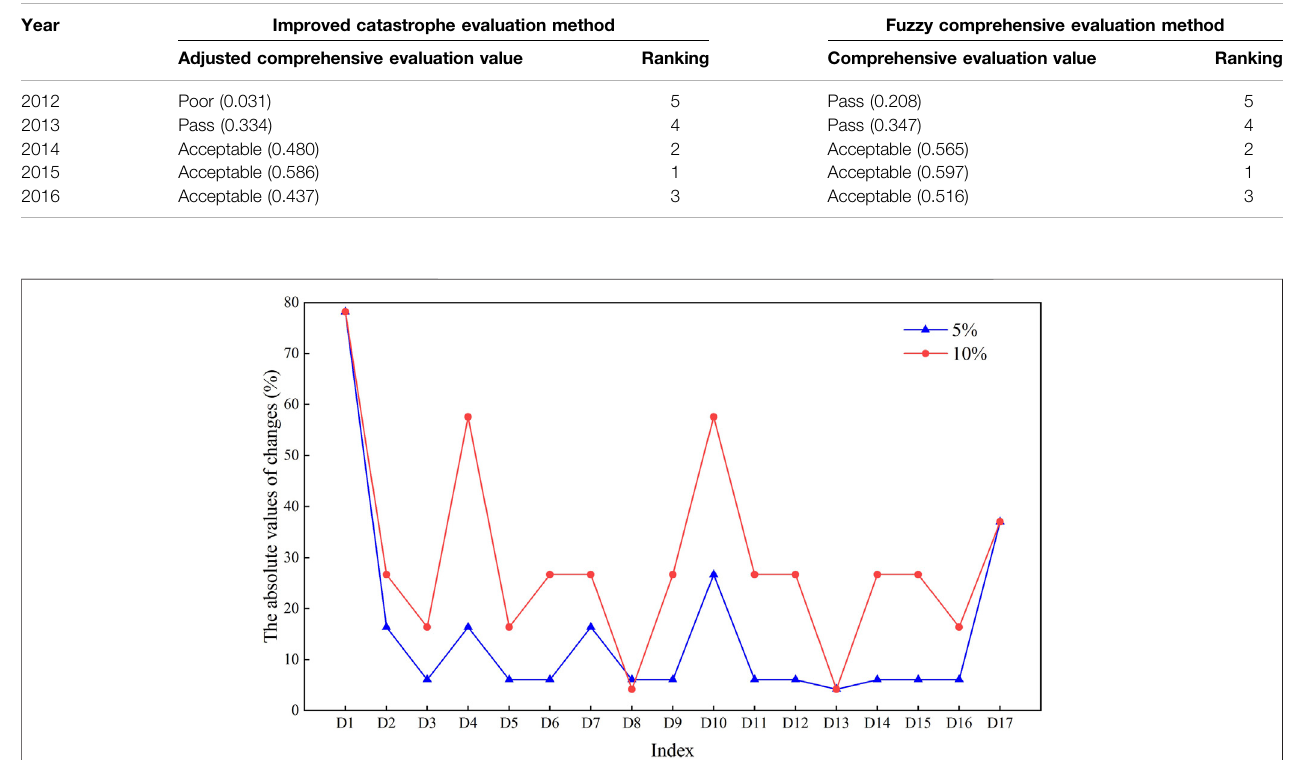
TABLE 7 | Comparison of two methods.